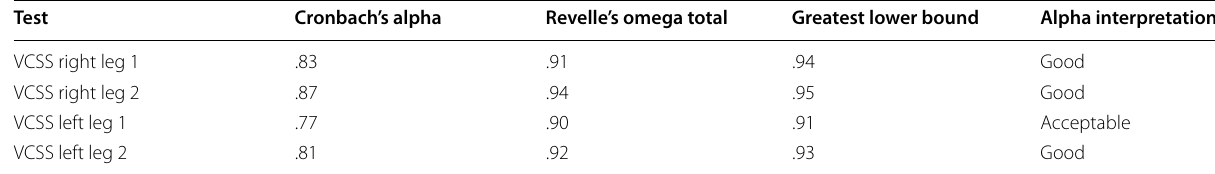
first examination, 2 second examination = =